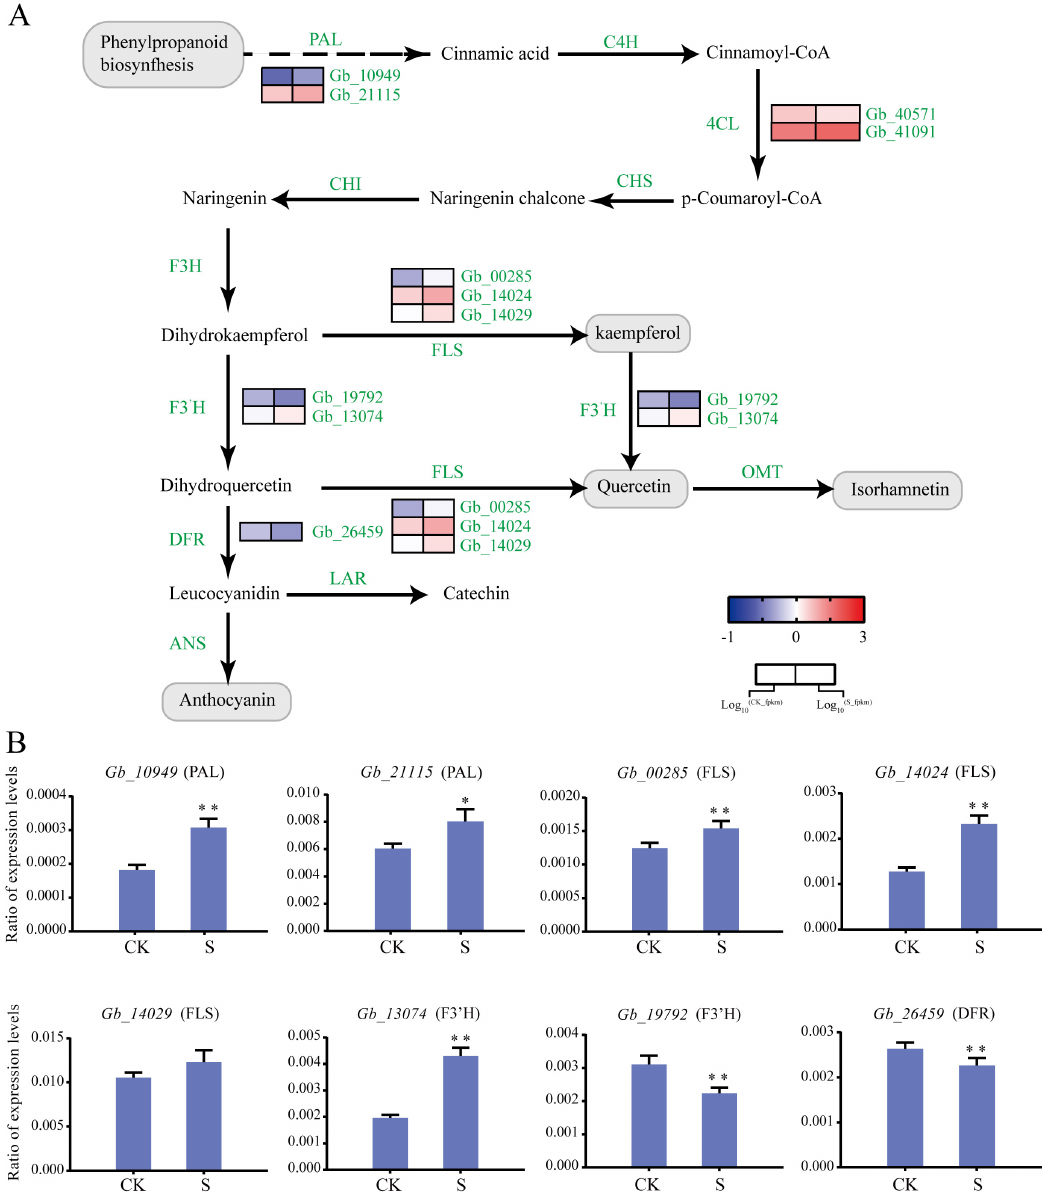
The vertical bars indicate SD ( n = 3).